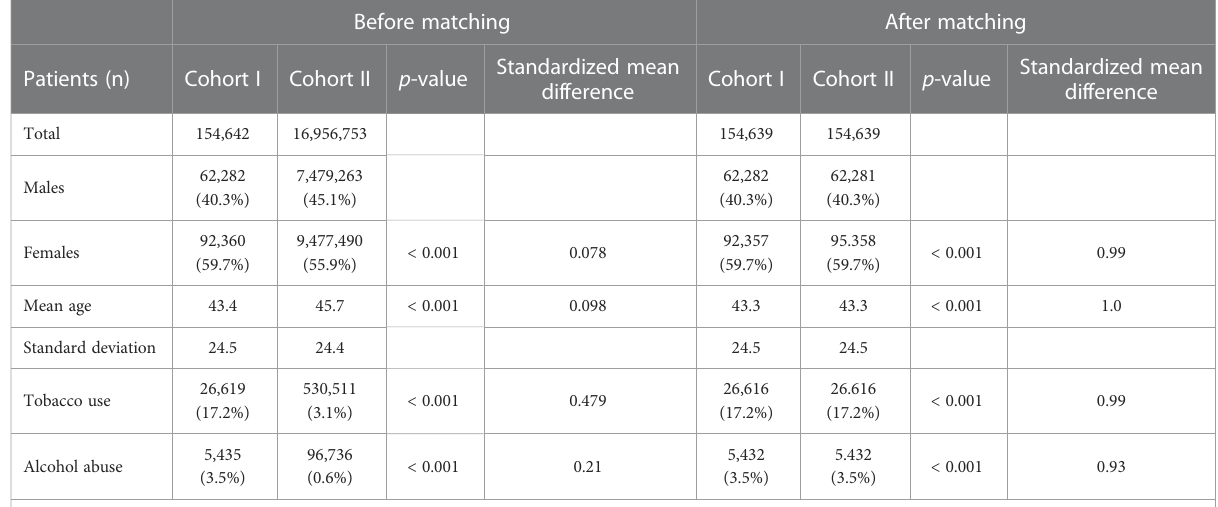
TABLE 1 Characteristics of the cohorts I (individuals with ICD-10 codes F45.8, and/or F59, and/or G47.63, and/or G47.8) and II (subjects without the respective diagnoses) before and after matching for age and gender, as well as tobacco use and alcohol abuse. Before matching